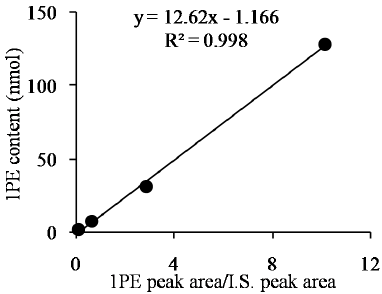
Figure 3. Standard 1PE curve using ethyl n -decanoate as an internal standard (IS). X -axis shows the GC-MS peak area ratio of 1PE to the IS. Y -axis shows 1PE content. The IS content was 5 nmol.